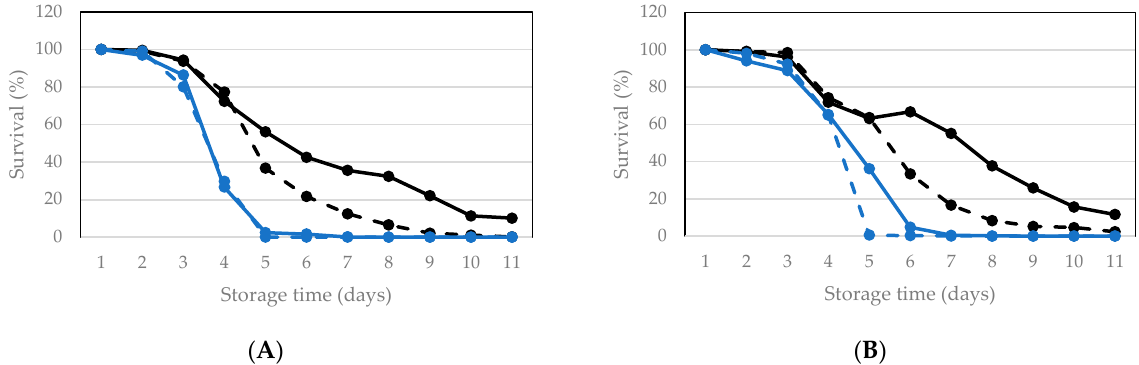
Figure 7. Survival of larvae during storage at room temperature ( A ) and at 15 °C ( B ) after being packaged and only sealed (no vacuum = control) and after being vacuum packaged. Each data point represents 1 package. Two experiments were performed with different batches of larvae: Control 1: black, full line, Control 2: black dashed line, Vacuum 1: blue, full line, Vacuum 2: blue dashed line.